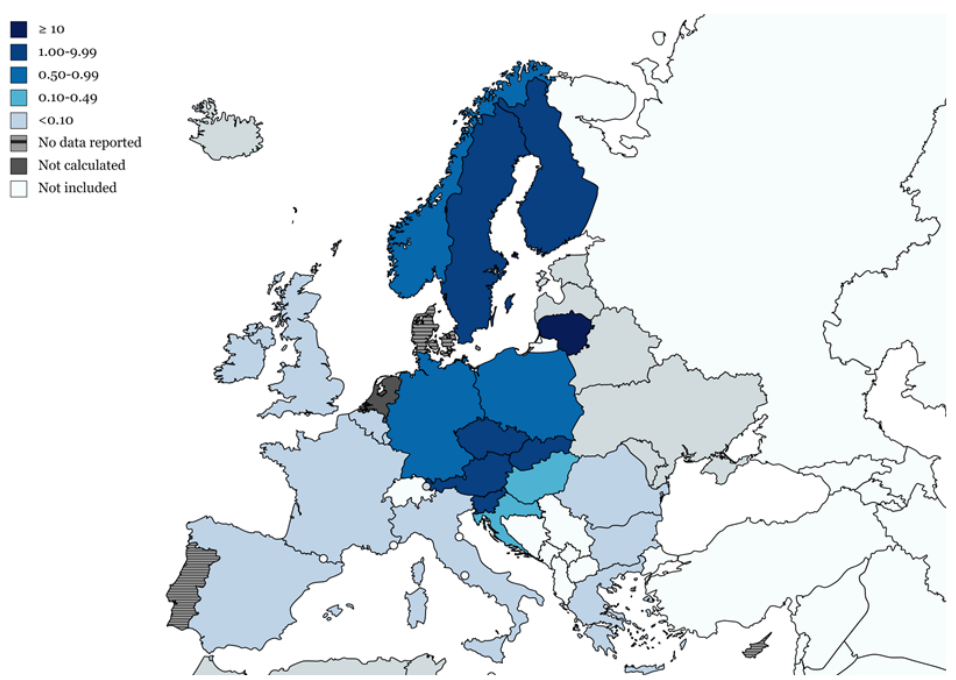
Figure 1. Distribution of confirmed tick-borne encephalitis cases per 100,000 population by country; EU/EEA, 2019 Source: Country reports from Austria, Belgium, Bulgaria, Croatia, Czechia, Estonia, Finland, France, Germany, Greece, Hungary, Ireland, Italy, Latvia, Lithuania, Luxembourg, the Netherlands, Norway, Poland, Romania, Slovakia, Slovenia, Spain, Sweden, and the United Kingdom (Adapted from [13]).